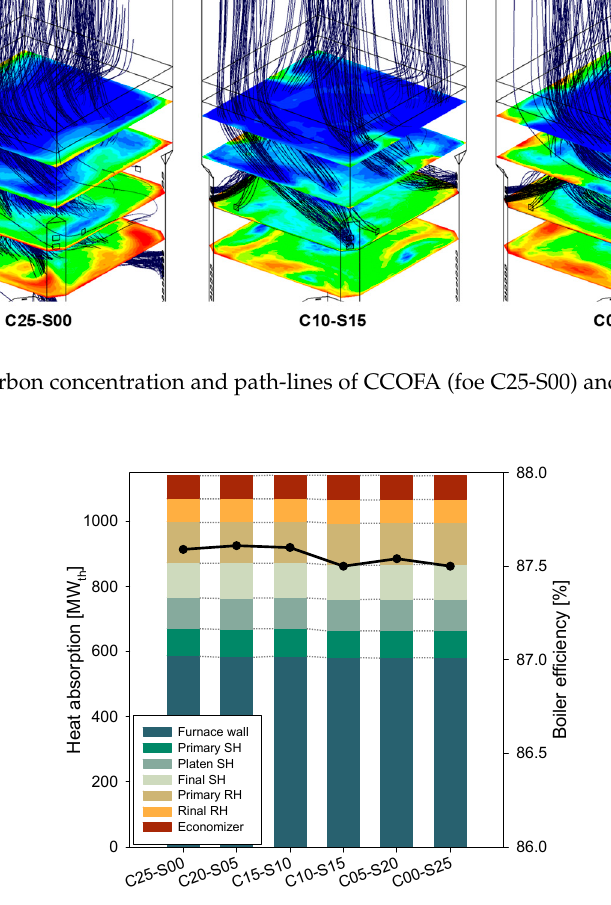
Figure 13. Comparison of heat absorption by heat exchangers and boiler efficiency for different CCOFA / SOFA distributions (total OFA ratio fixed at 25%).